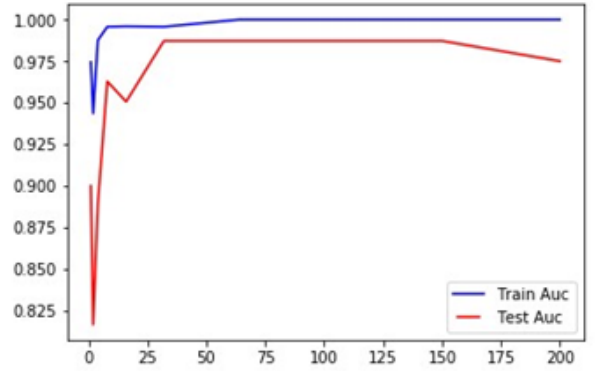
Figure 5. RF classification report.